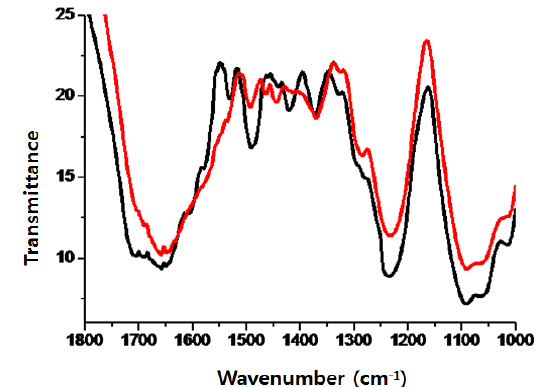
Figure 2. FT-IR spectra of natural DNA (black color) and DNA-Au(III) complex (red